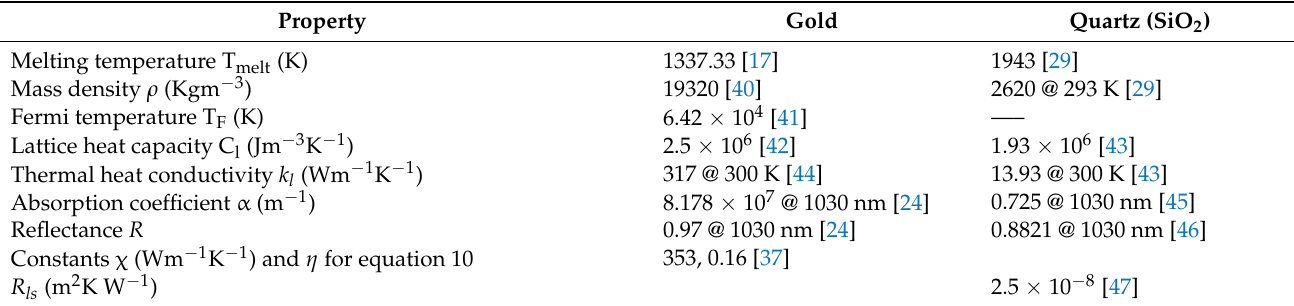
Table 3. Thermophysical properties of gold and quartz used in the model.